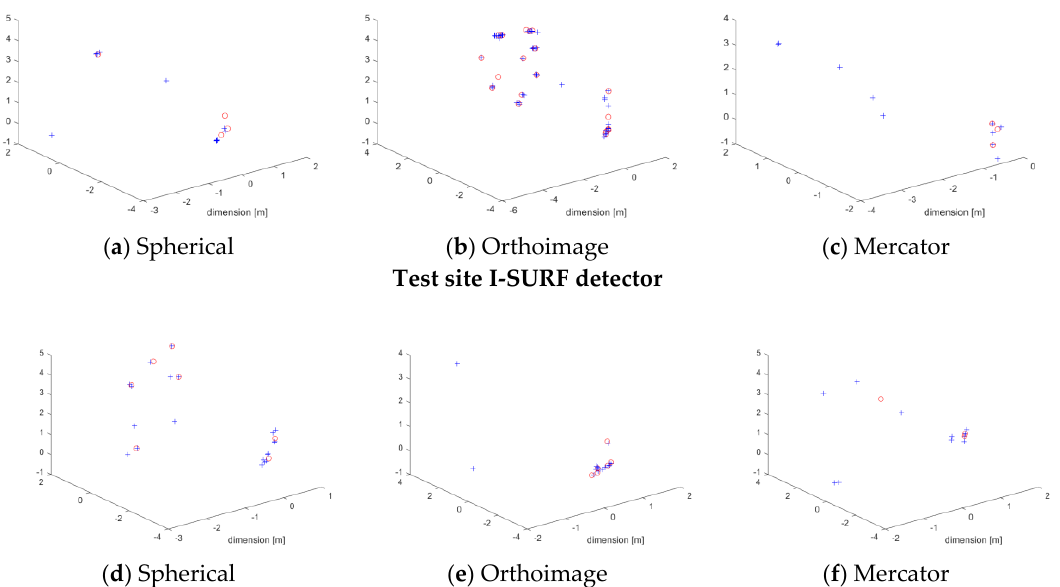
Figure A.4. Distribution of points used in the TLS data orientation process for the pair of scans for the scanner stations for test sites III : “The office room” -the worst distribution of the control (blue) and check points (red). Points detected by FAST ( a – c ) and SURF ( d – f ) detectors on raster images: ( a/d ) in the spherical projections, ( b/e ) in the orthoimage and ( c/f ) in the Mercator projection.